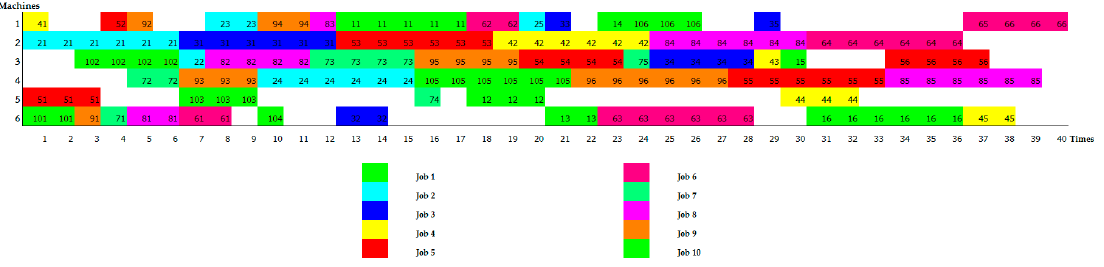
Figure 8. Gantt chart of solutions for flexible job shop scheduling problem Mk1 presented by Brandimarte [30].